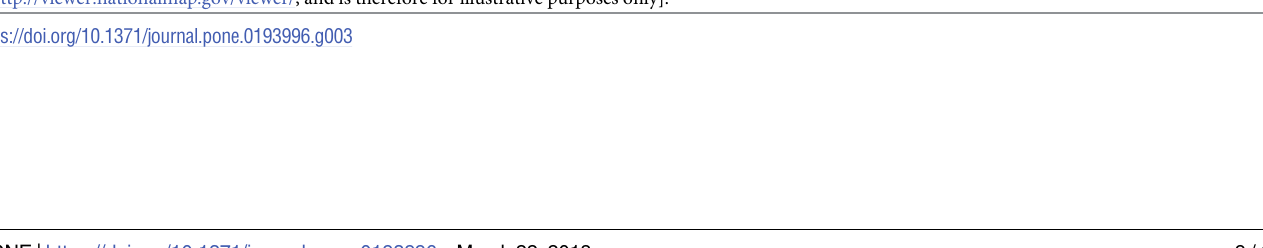
PLOS ONE | https://doi.org/10.1371/journal.pone.0193996 March 22,